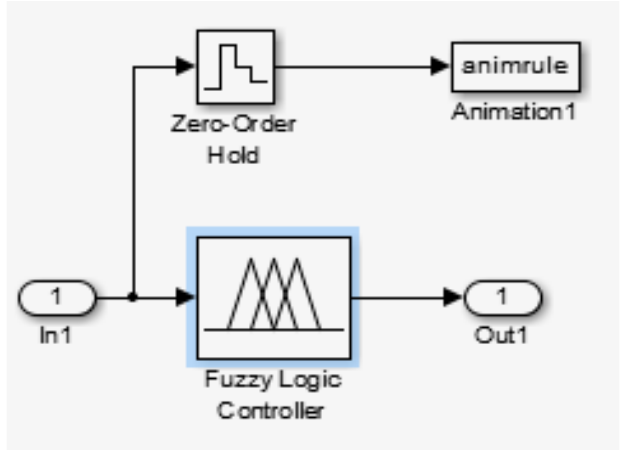
Figure 7. Fuzzy controller Simulink model.